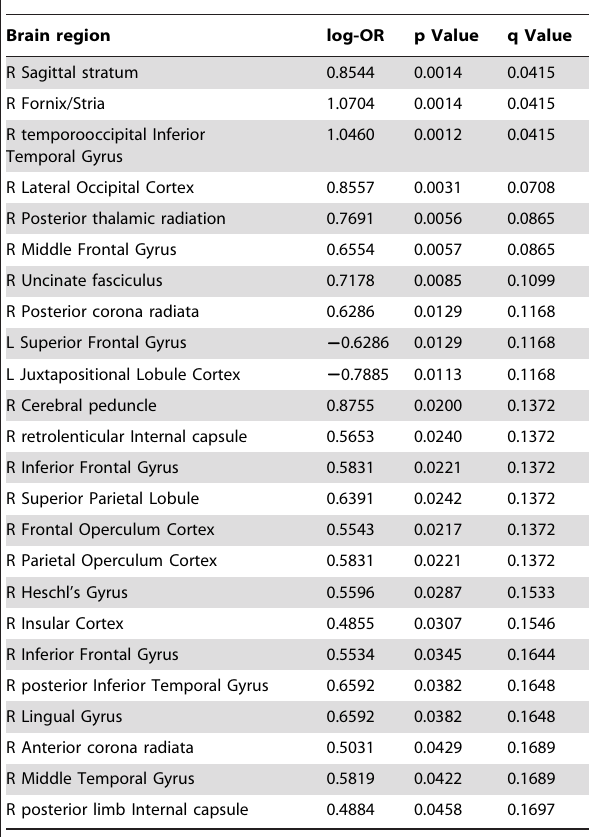
Table 4. Univariate log-OR for supratentorial anatomic brain regions associated with HAP (as defined by p , 0.05) and false discovery rate